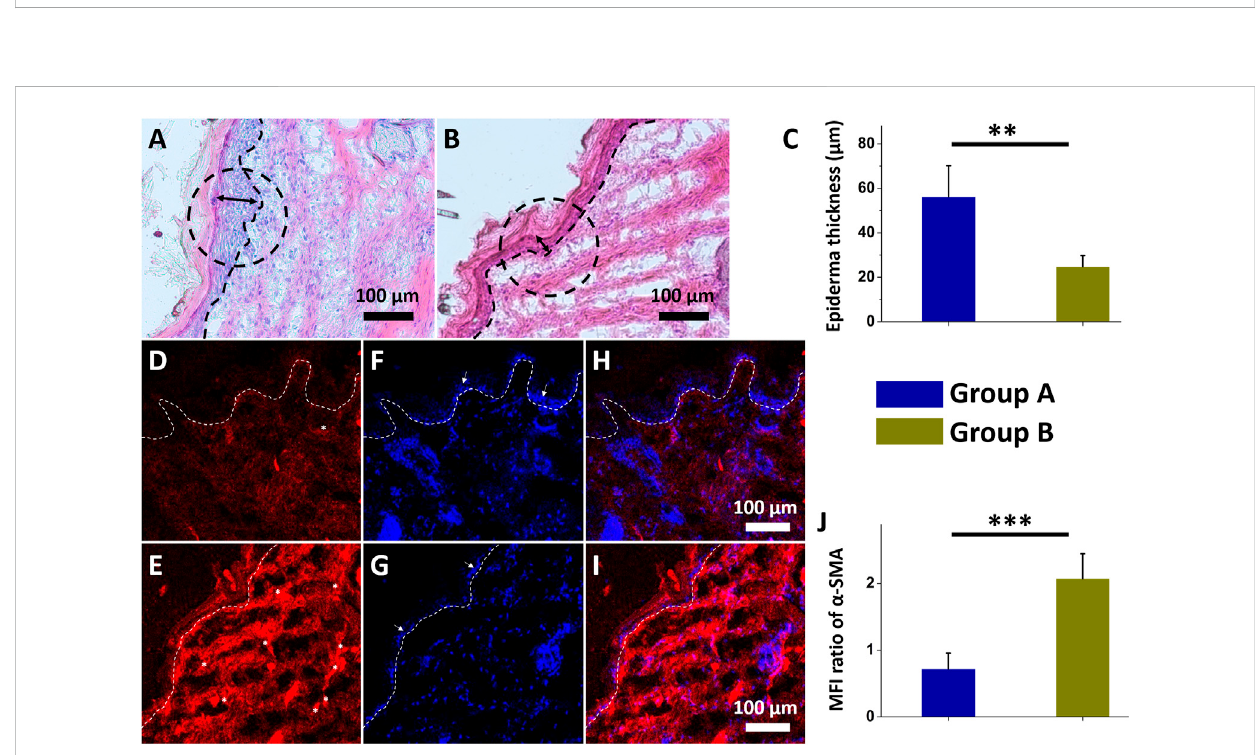
FIGURE 6 Histological images of insulin/vildagliptin-eluting PLGA group (Group A) (A) and insulin/PLGA (Group B) (B) after two weeks. The treated wound sections showed deeper epidermis (double arrow area and black circular dashed line) and in fi ltration of the cells on dermis area (below black dot line) in groupA (C) .Immuno fl uorescenceof α -SMAingroupA (D) andgroupB (E) .PhotosofDAPI-labelednuclei(blue) (FandG) ,andmergedimages (HandI) of two groups. The white arrow (F and G) indicated the epidermis, consistent with the above results (C) . α -SMA (white asterisk) immunocytochemistry was analyzed relative to that of DAPI using MFI (J) (Scale bar = 100 μ m). ** p < 0.01, *** p < 0.001